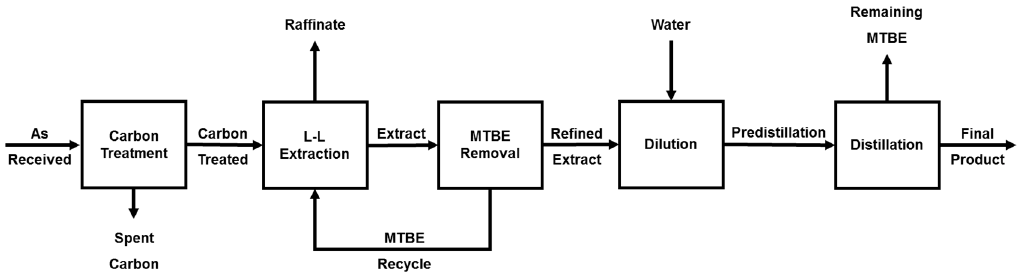
Figure 7. Clean up protocol for bio-oil aqueous phase prior to testing adapted from Davidson et al.[13].